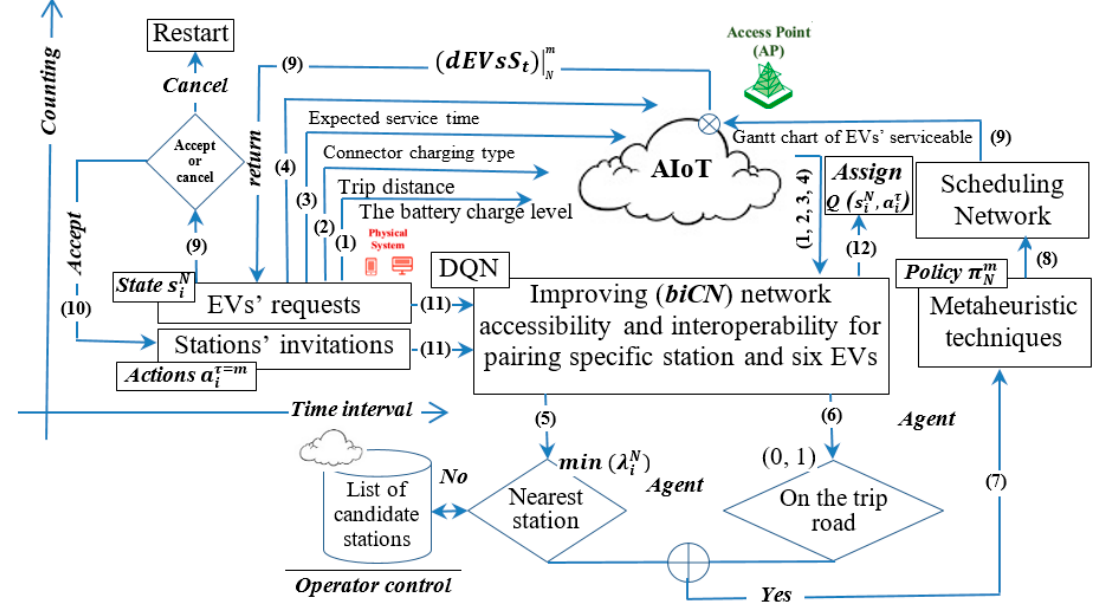
Figure 5. The stages of the methodology